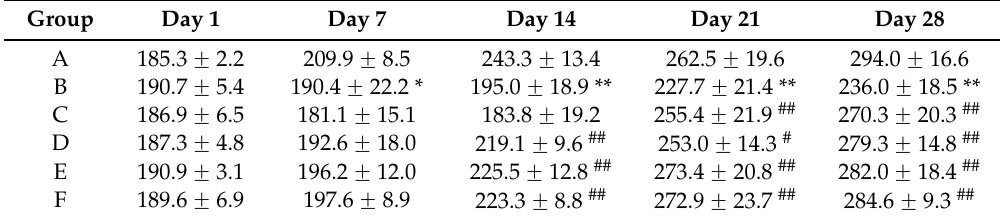
Table 1. Changes of body weight after drugs intervention ( n =